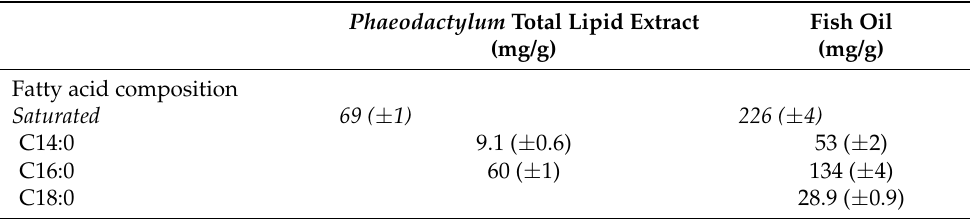
Table A1. Fatty acid and carotenoid composition in mg/g of Phaeodactylum total lipid extract and pure fish oil (mean ± sd, n =